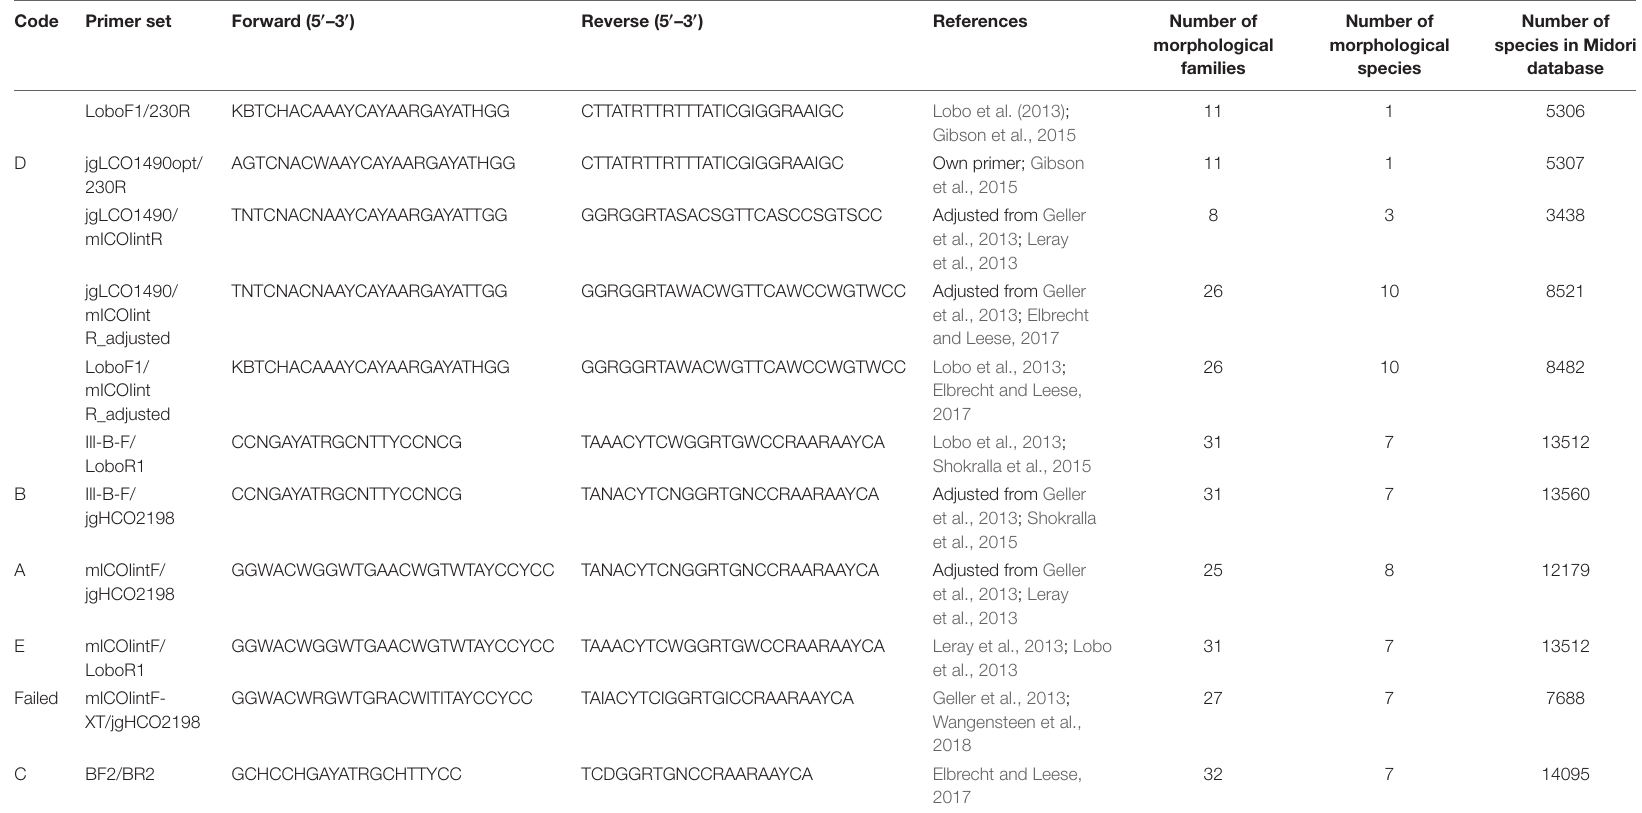
TABLE 1 | Overview of the COI primer sets used for in silico testing against the Midori marine database.